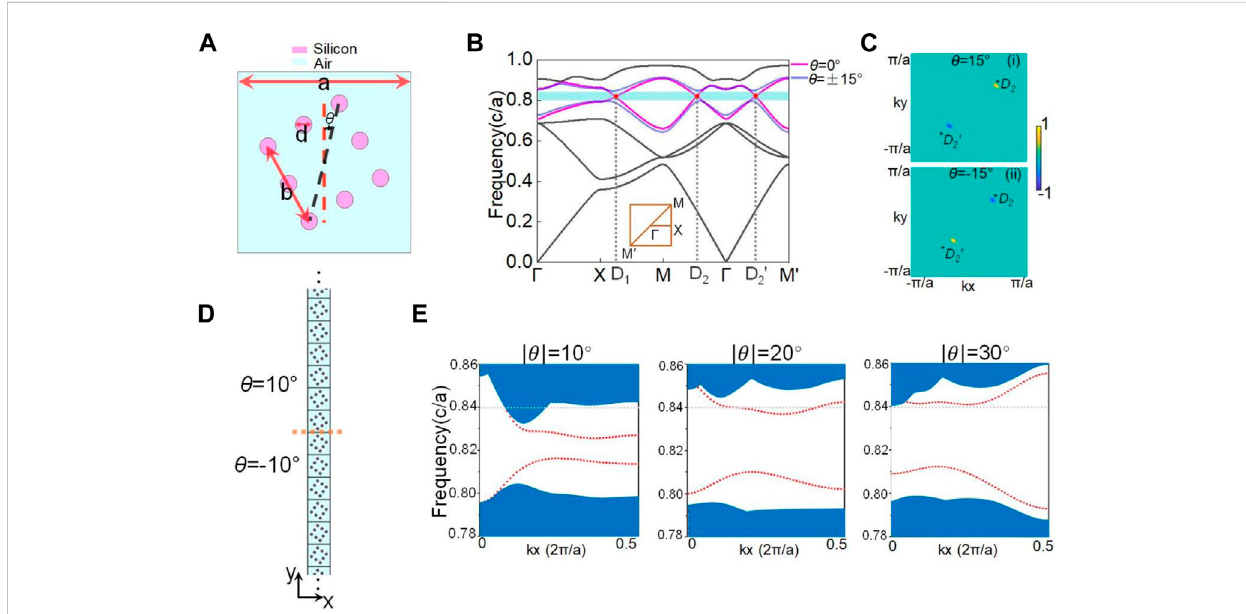
FIGURE 1 (A) Unit cell schematic representation with θ = 15 ° . Purple represents silicon, and cyan represents air. (B) Band structure diagram. The dark lines are thebandscommontocellswith θ =0 ° and±15 ° .When θ =0 ° ,thepurplelinesshowthefourthand fi fthbands,anddegeneratepointsaremarkedwithred. When θ =±15 ° ,thebluelinesshowthefourthand fi fthbands,andthecyanregionisthecorrespondingbandgap.The fi rstBZwithhighsymmetrypointsis shown in the inset. (C) Berry curvature distribution on BZ of the fourth band when θ = 15 ° and θ = − 15 ° . (D) Supercell schematic representation. θ above and below the orange dashed line is 10 ° and − 10 ° , respectively. (E) Three pictures are the projected band structure of supercells with | θ | = 10 ° , 20 ° , and 30 ° . The blue region represents the bulk band, and the red dotted line represents the edge states. The gray dotted line denotes the frequency of 0.840 c/a